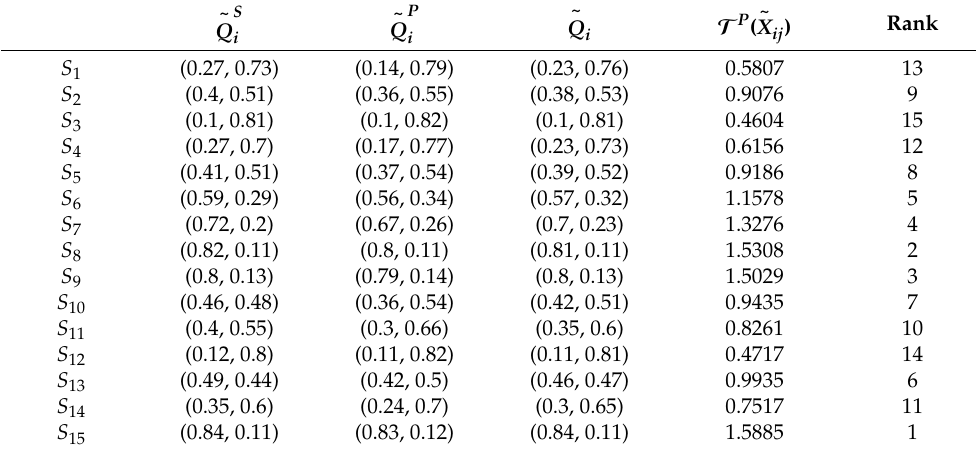
Table 7. The measures of FF-WASPAS and final ranks.